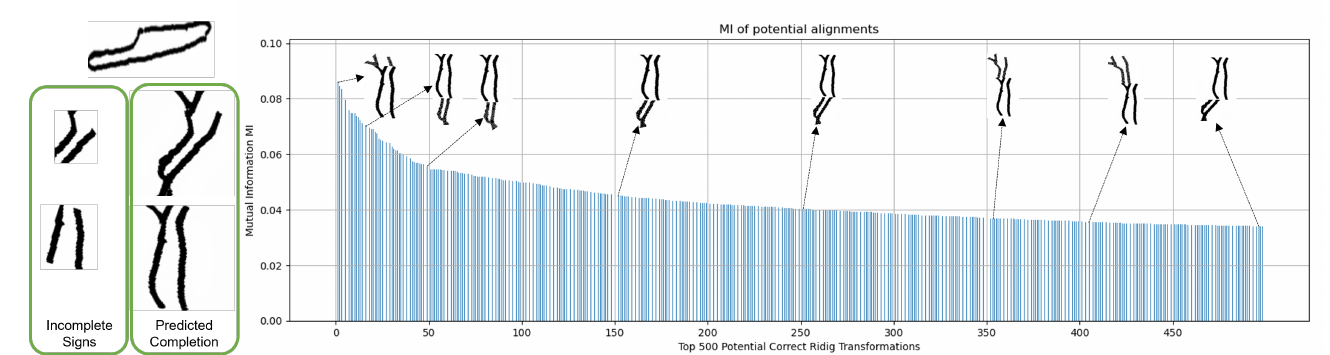
Figure 14. Example of the top 500 potential signs alignments based on MI for the feather sign. The Y -axis is the MI value, and the X -axis corresponds to the respective alignment